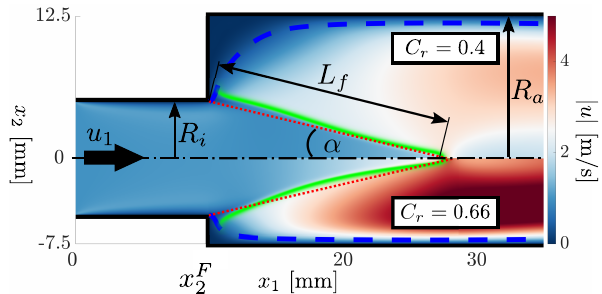
Figure 7. CFD steady state absolute velocity for a confinement ratio of C r = 0.4 (upper half) and C r = 0.66 (bottom half). For both configurations, the location of maximum heat release ( ), the analytically predicted mean flame front ( ) and the approximate location of the shear layer ( ) are also